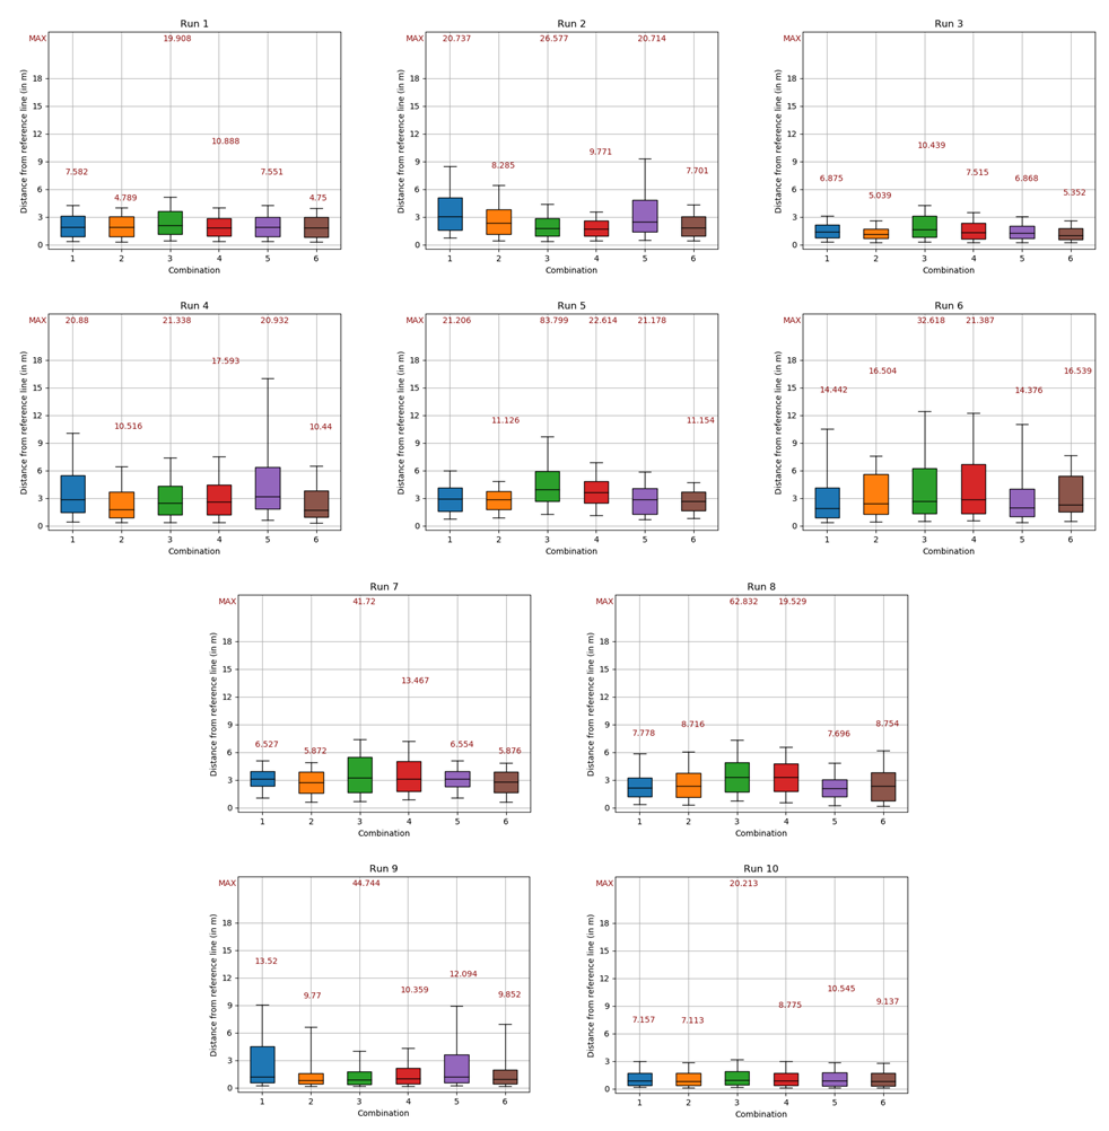
Figure A5. Boxplots of perpendicular distances of points falling in areas cover by trees for all combinations and all